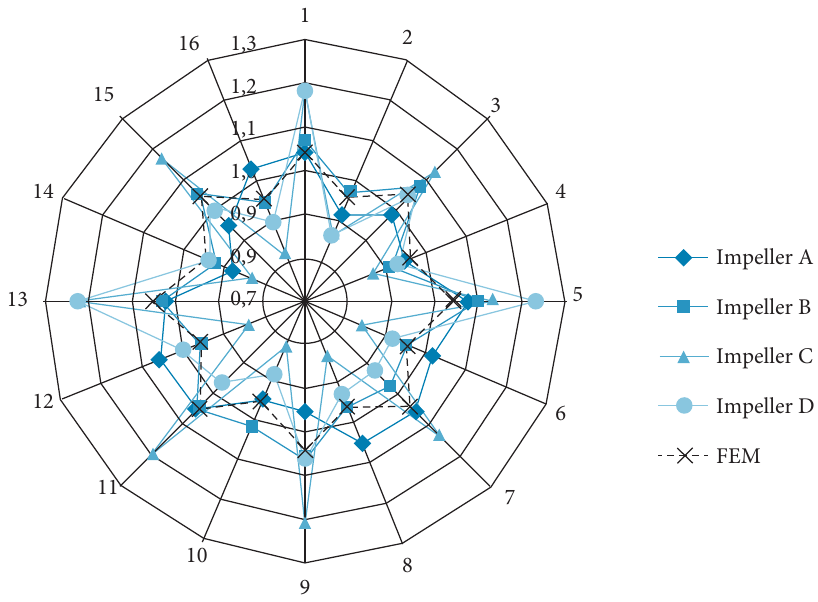
Figure 14. Normalized expansion values at circumferential directions for nominal rotational speed (100%).